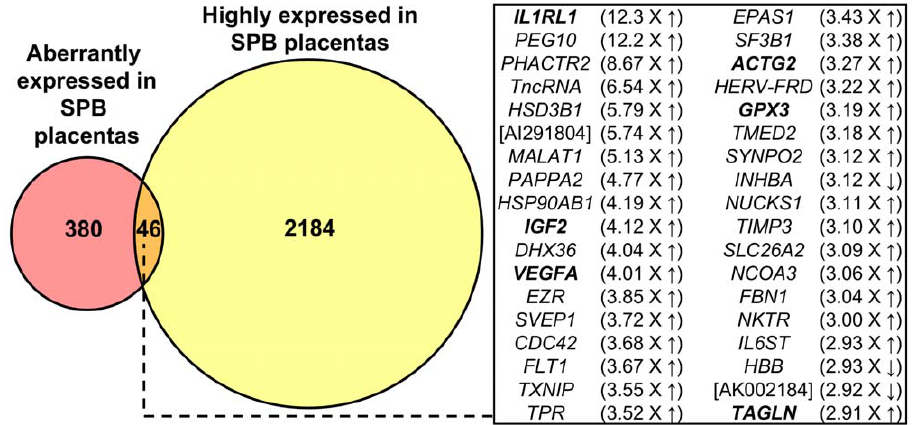
Figure 1. Systematic identification of SPB-associated placental transcripts in maternal plasma. Shown in the Venn diagram are the number of microarray probesets representing transcripts which are highly expressed (pale yellow) and aberrantly expressed (red) in the SPB placentas. Transcripts fulfilling both criteria (orange) are potentially detectable in maternal plasma samples obtained from women eventually resulting in SPB. These probesets represent 36 transcripts and are shown in the box, along with the fold-change up-regulated (up arrow) or down- regulated (down arrow) in the SPB placentas, compared with the STB placentas. For transcript represented by more than one probesets, its average fold-change is shown. Transcripts with no official gene symbols are shown in their GenBank accession numbers. Transcripts chosen for RT-qPCR are shown in bold. SPB, spontaneous preterm birth. STB, spontaneous term birth.